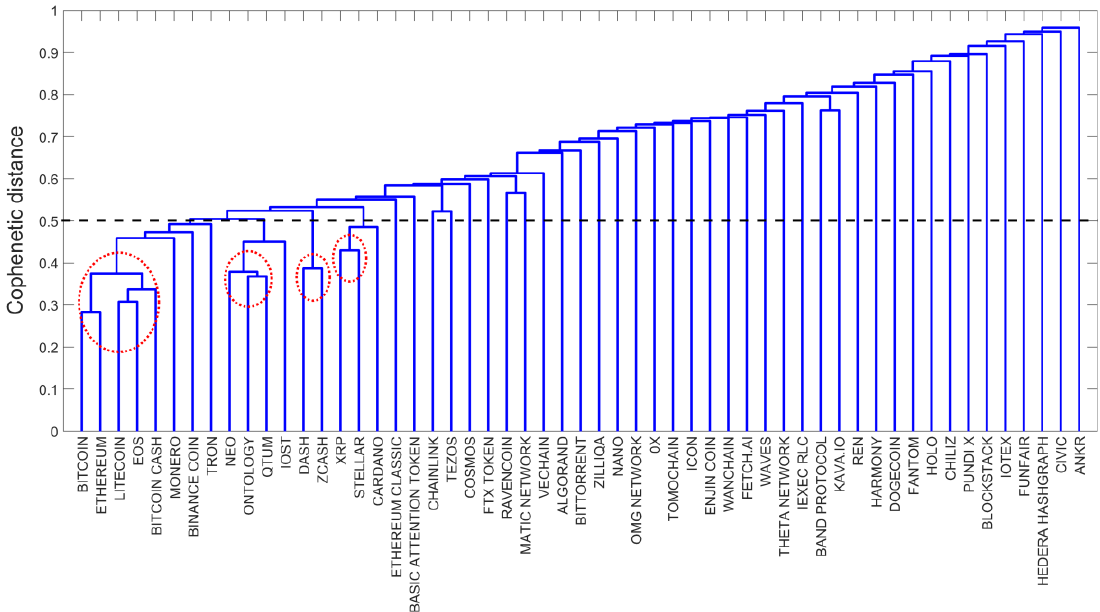
Fig. 6. IFC based dendrogram. The dendrogram/binary cluster tree was constructed using a distance metric D for each pair of cryptocurrencies 𝑖 and 𝑗 where IFC is the = 1 − IFC ij ij normalized total iso-frequency coupling between them. The height (cophenetic distance) of a link in this dendrogram represents the distance between the corresponding two clusters that contain any two cryptocurrencies. Visually identifiable clusters with link height < 0.5 are demarcated by red